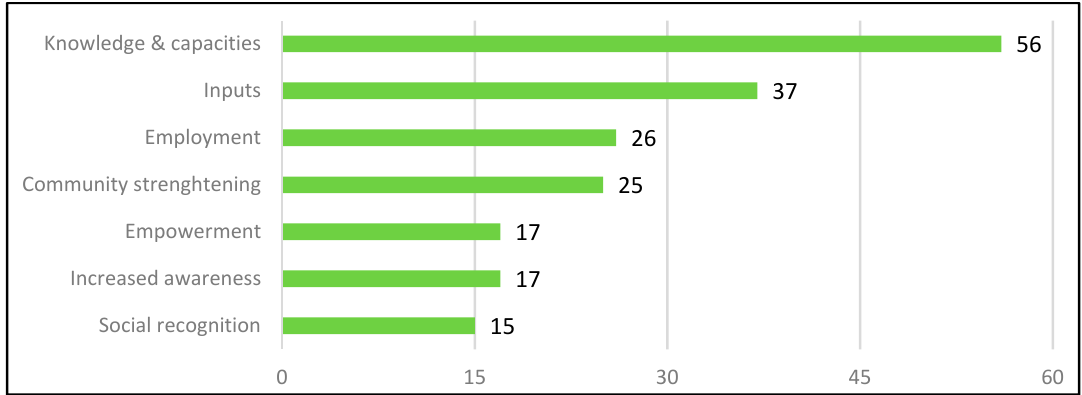
Figure 6. References to ES-unrelated social benefits in the Chingaza case study (own representation).